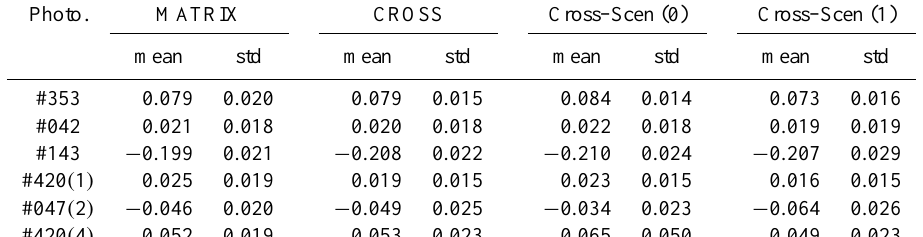
= ξ θ ) of several Sun photometers in the preliminary result tests. Table 3. Summary of the vertical pointing error ( 2 ξ θ Photo.